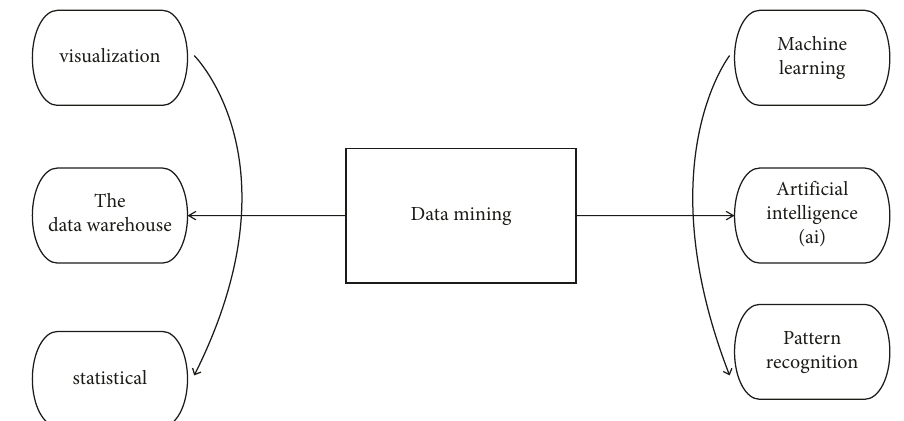
Figure 6: Data mining model diagram.